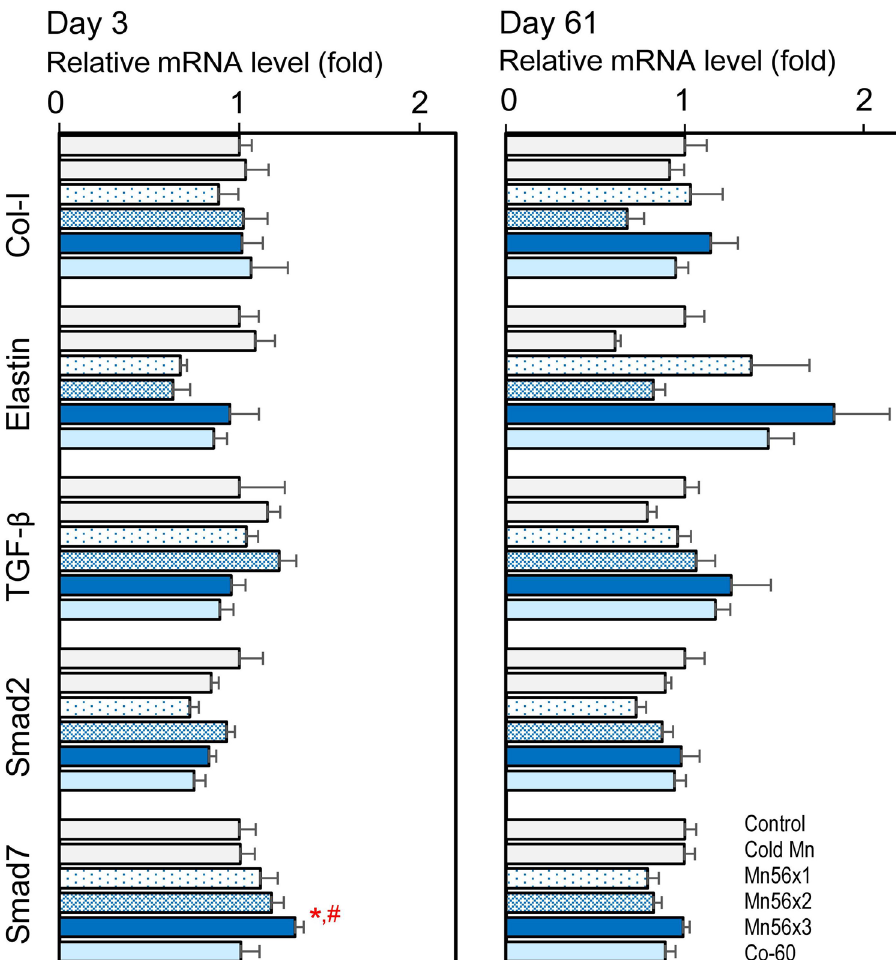
Figure 3. Relative mRNA expression levels of collagen-I, elastin, TGF-β, Smad2 and Smad7 genes in the lungs of rats on day 3 (left) and day 61 (right) after the exposure to 56 MnO 2 powder (Mn56x1, Mn56x2, Mn56x3), Cold MnO 2 powder (Cold Mn) or 60 Co-γ exposure (Co-60). *p < 0.05 vs. control; # p < 0.05 vs cold